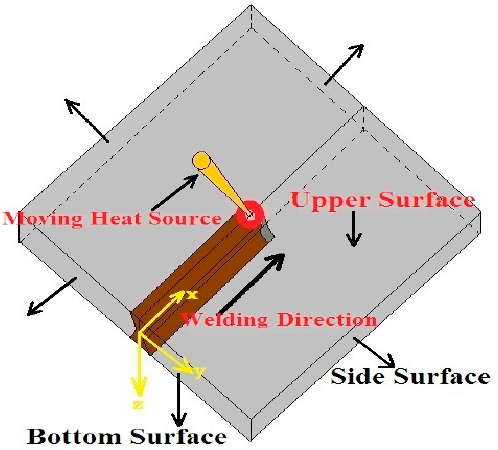
Figure 3. Schematic model for laser welding.